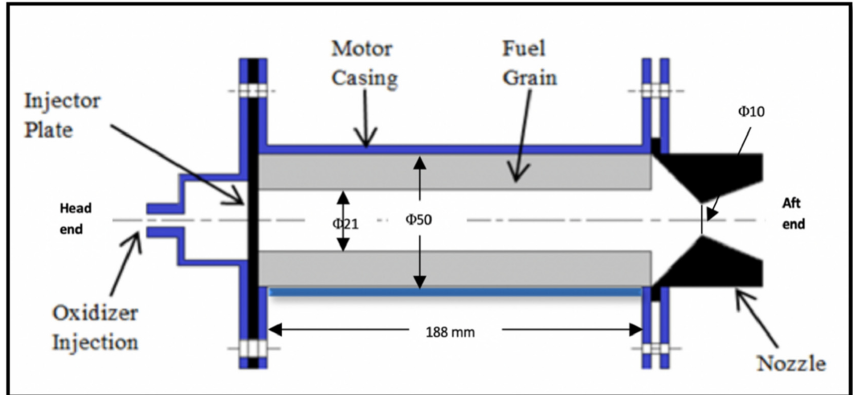
Figure 2. Schematic of lab-scale model of hybrid rocket motor.